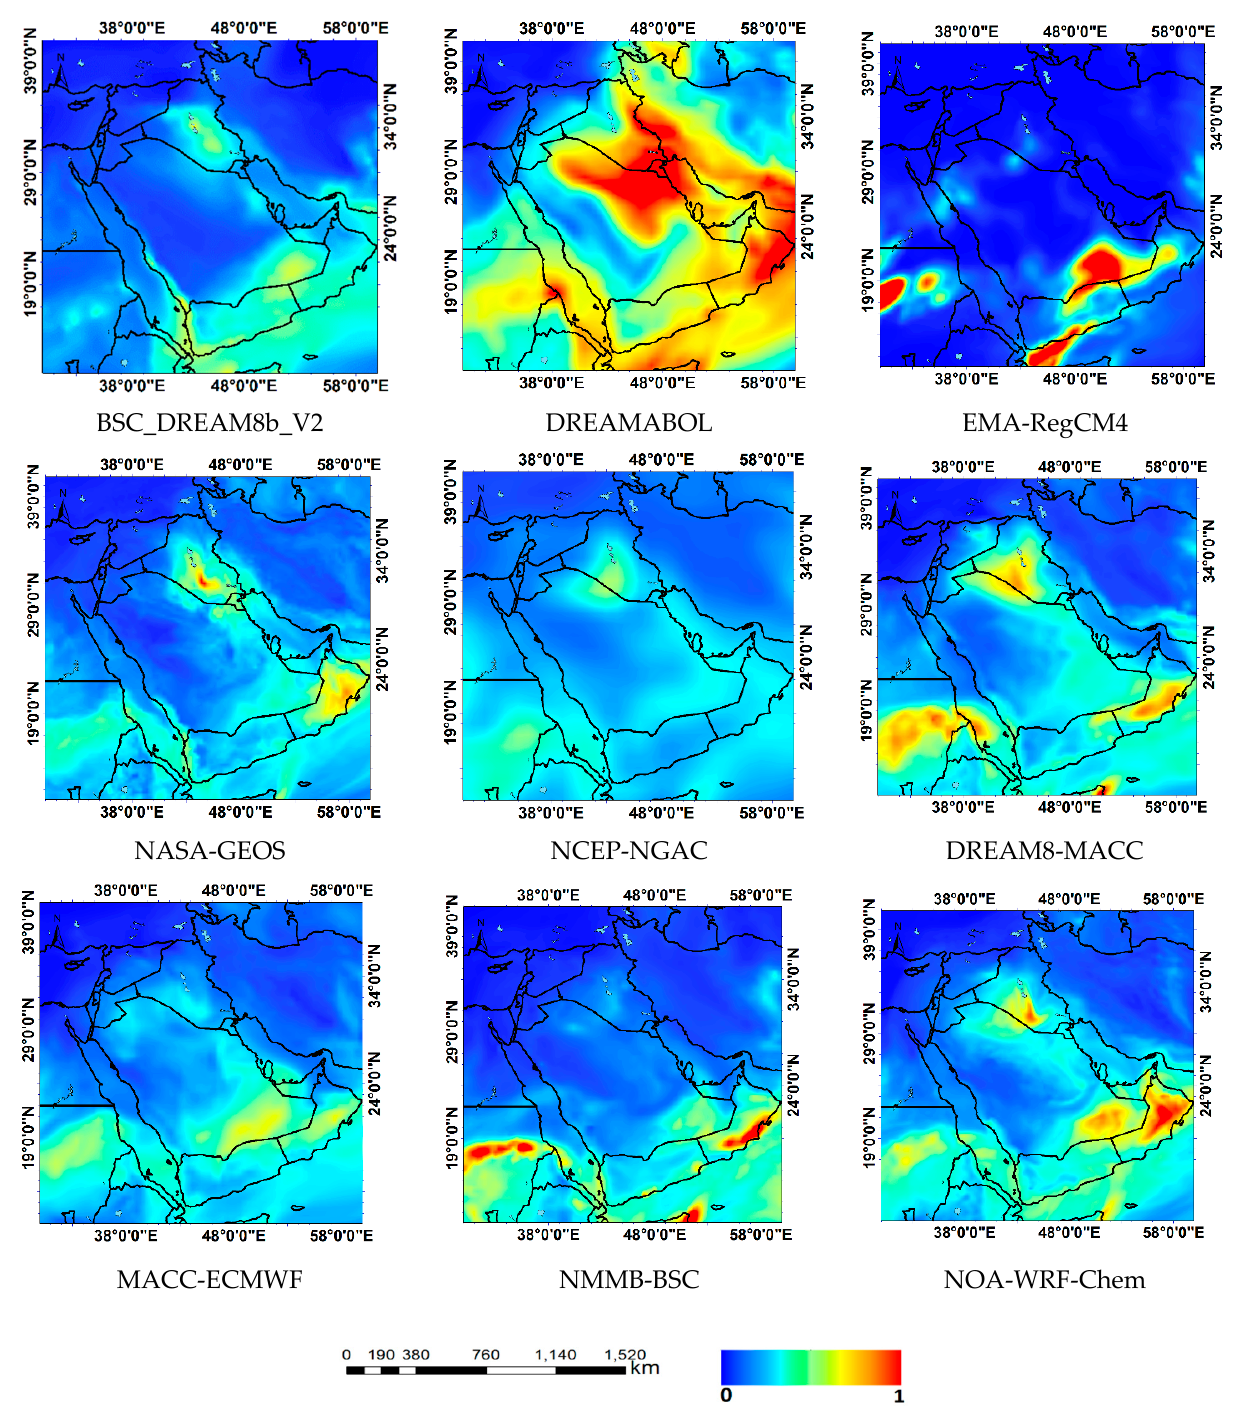
Figure 7. Spatial distribution of AOD forecasts from the nine examined models at 07:00 UTC on 5 July 2017 (Shamal dust storm).